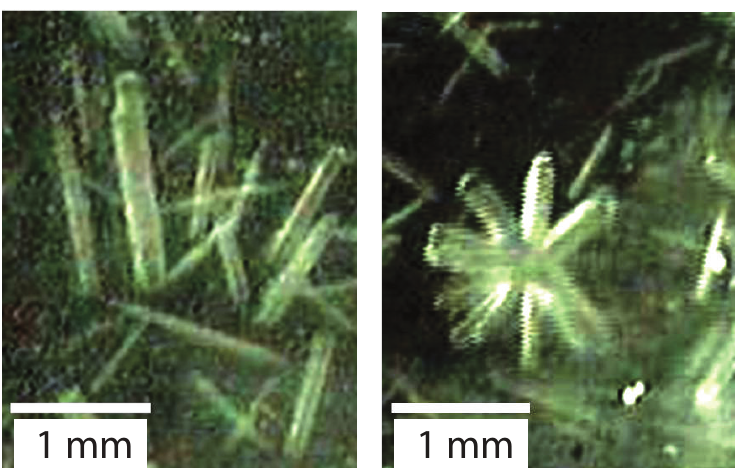
Figure 3: The photos of TBAB hydrate; (a) typical rod-like particles, (b) typical aggregation